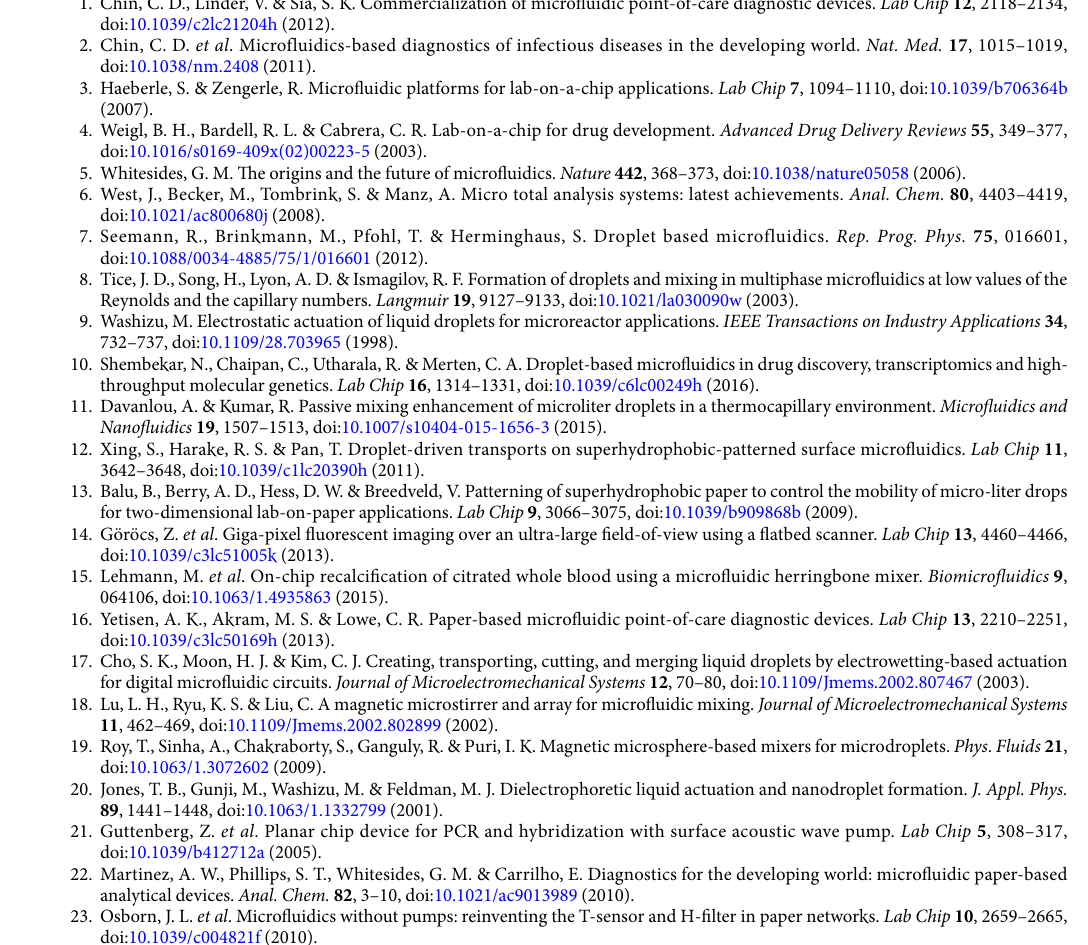
According to the above definitions, the values of η would range from 0 to 1 – unity denoting perfect mixing, and zero implying no mixing. The rationale of calculating the mixing efficiency is provided in the SI (Section S5 and Fig.